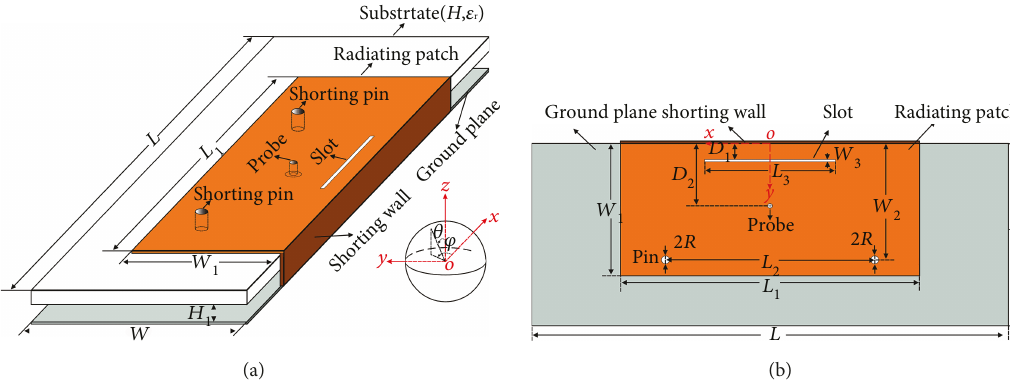
Figure 3: A dual-mode PIFA designed to enhance the BW [18].